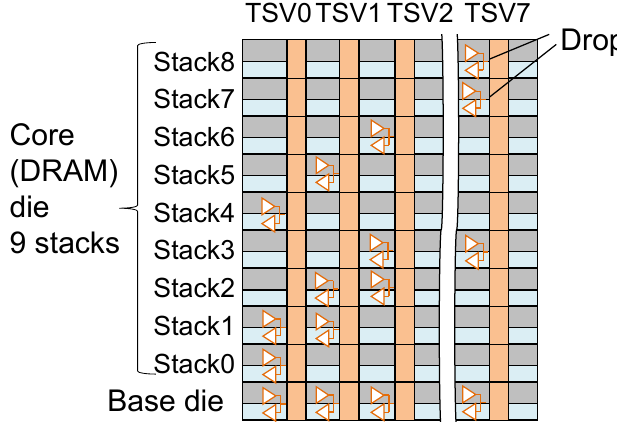
Figure 32. Configuration of BBCube.